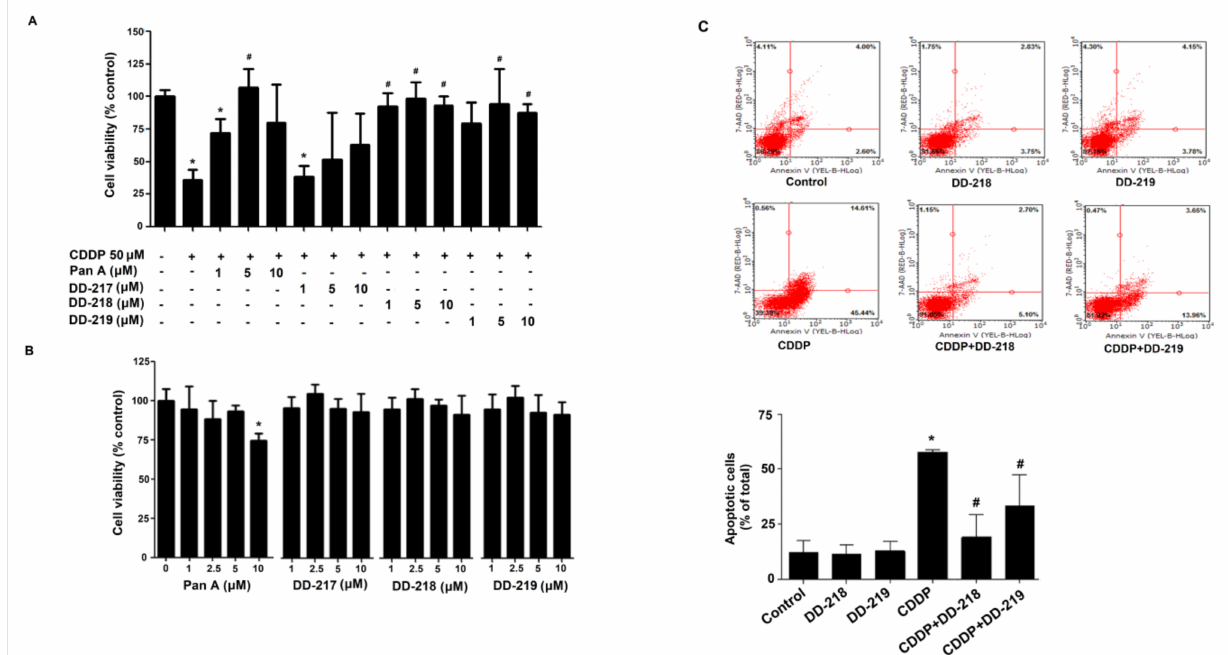
Figure 2. Effects of panduratin A and its derivatives on the cytotoxicity of CDDP in human renal proximal tubular cells. ( A ) RPTEC/TERT1 cell viability was measured following treatment for 72 h with: 0.1% DMSO (control): 50 µ M CDDP alone; with co-incubation of panduratin A (PanA), DD-217, DD-218, DD-219 each at concentration of 1, 5, and 10 µ M. ( B ) Viability of RPTEC/TERT1 cells was measured following treatment for 72 h with: 0.1% DMSO (control), panduratin A, DD-217, DD-218, DD-219 each at concentration of 1, 2.5, 5, and 10 µ M. ( C ) Apoptosis of RPTEC/TERT1 cells was measured following treatment for 48 h with: 0.1% DMSO (control); 5 µ M DD-218; 5 µ M DD-219; 50 µ M CDDP; 50 µ M CDDP combined with 5 µ M DD-218 (CDDP+DD-218); 50 µ M CDDP combined with 5 µ M DD-219 (CDDP+DD-219). Percentage of cell viability and apoptosis is shown as mean ± SD from at least 3 independent experiments: * p < 0.05 compared to control; # p < 0.05 compared to CDDP